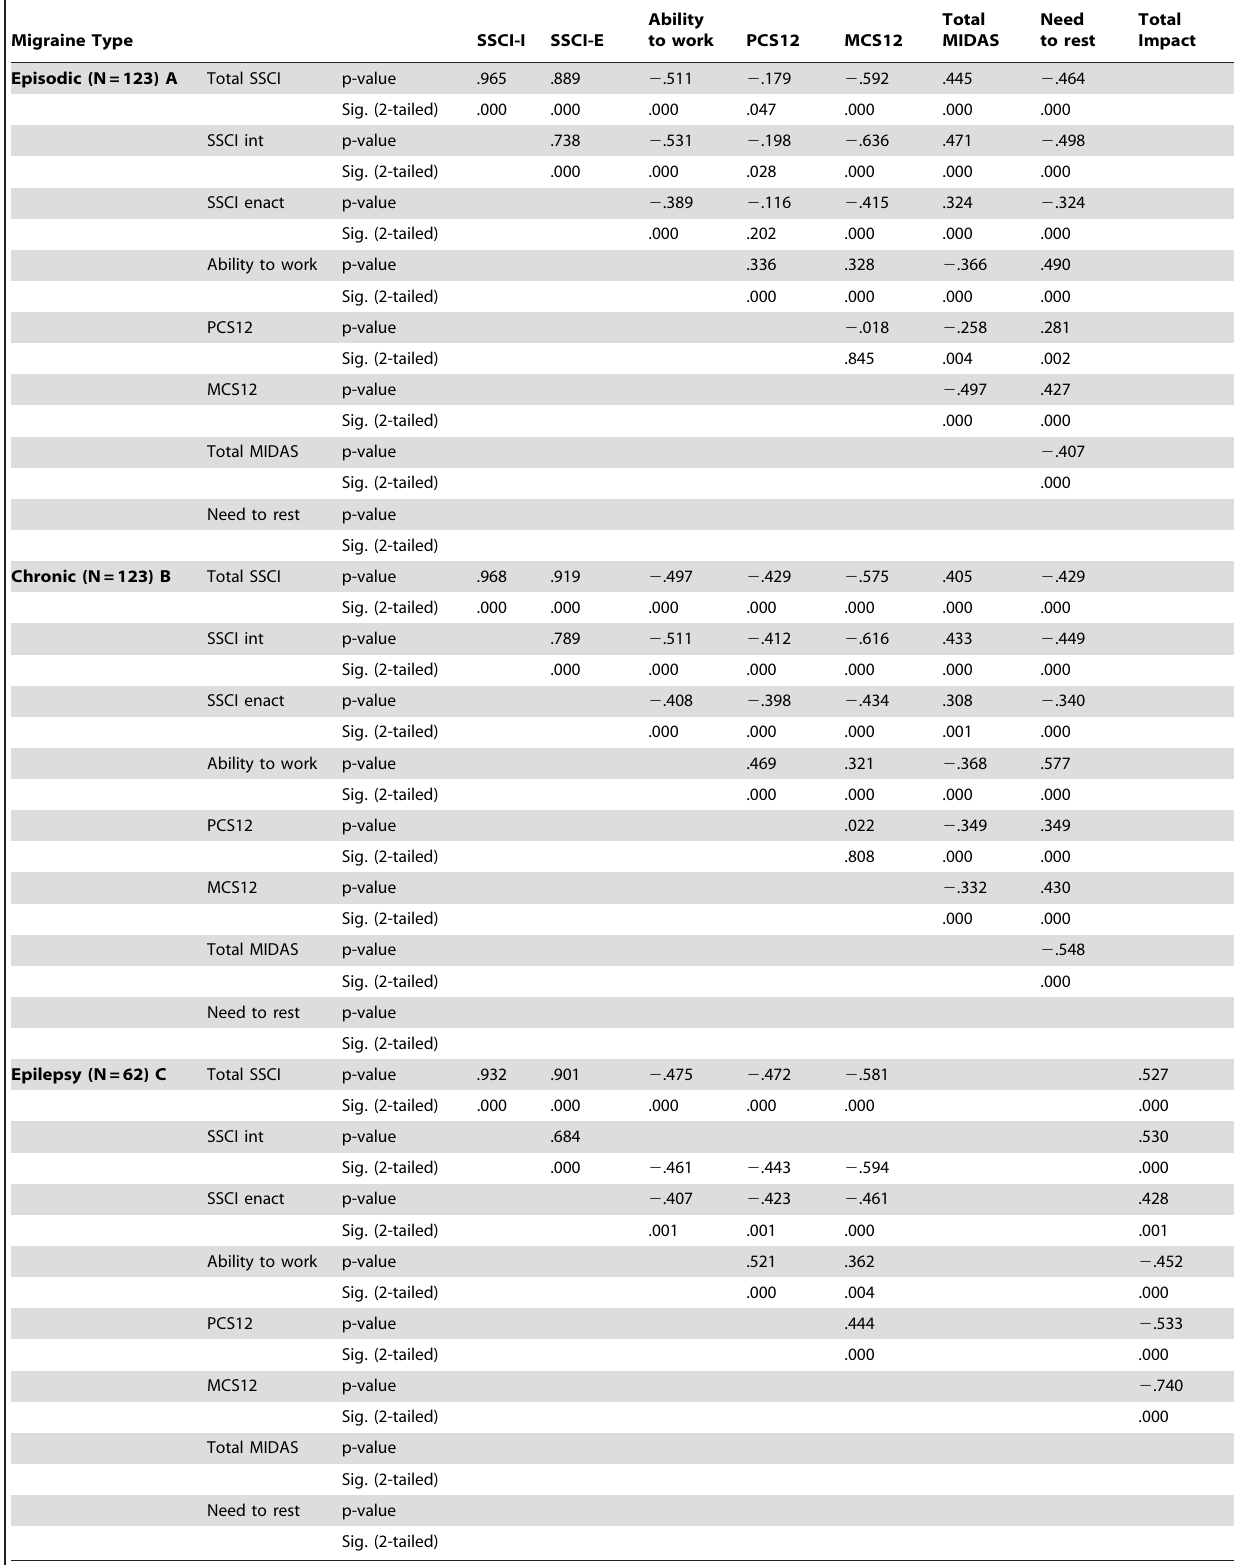
Table 3. Correlations Between